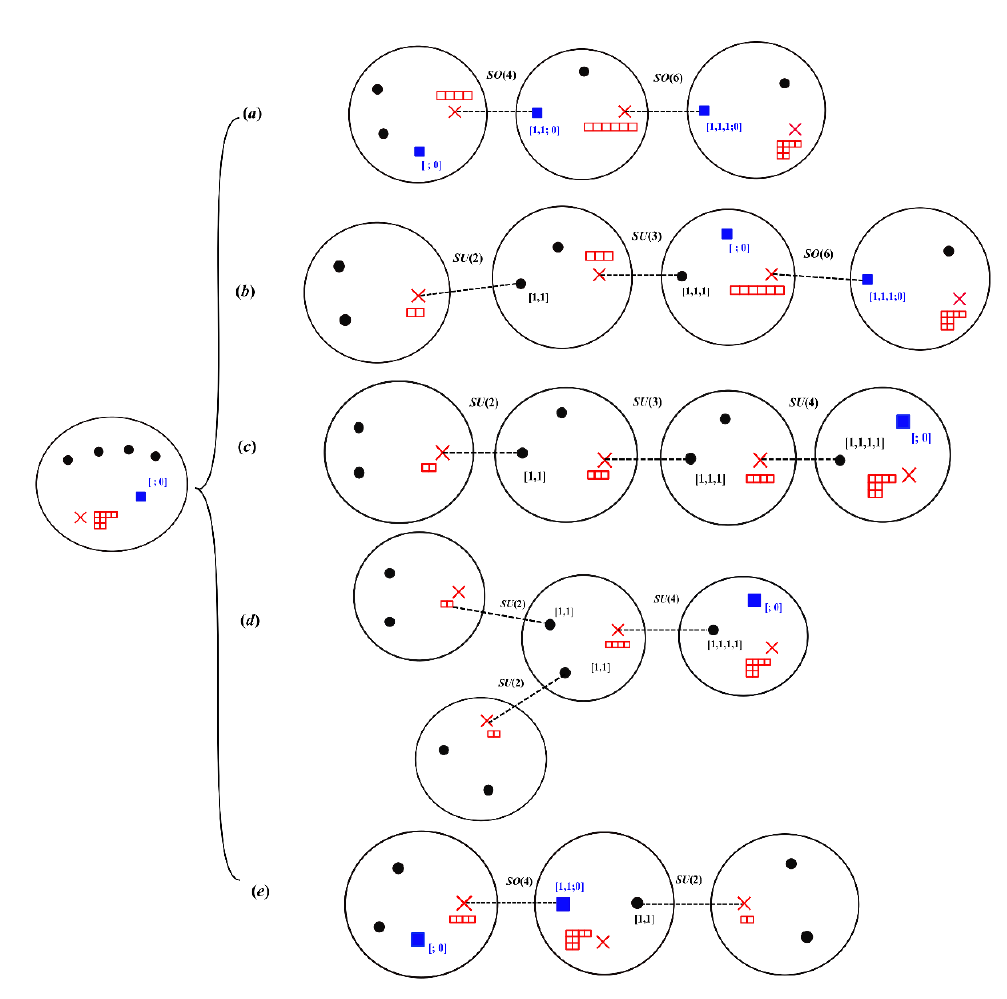
Figure 7 . The weakly coupled duality frame for D 4 theory of class ( k; 1). For ( a ), the leftmost theory is two copies of ( A 1 ; D 2 k +2 ), the middle theory is given by rightmost theory is given by